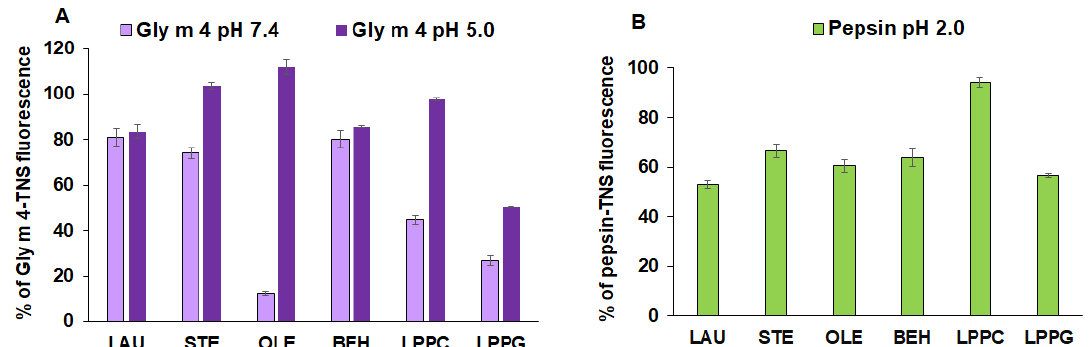
Figure 1. The effect of fatty acids and lysolipids on the fluorescence level of the Gly m 4-TNS ( A ) and pepsin-TNS ( B ) complexes. The results are expressed as the mean values (±SD) of the percentage of fluorescence using the protein-TNS complexes without ligands as controls.